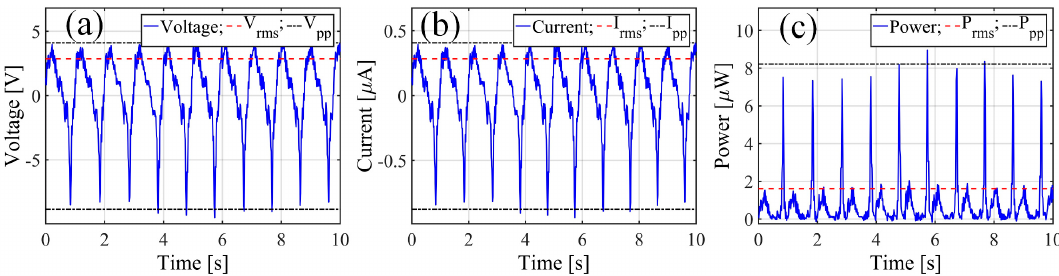
Figure 4. Output responses of the Stretchable TrEG while elbow motion ( a ) voltage, ( b ) current and ( c ) corresponding power for RL of 10.1 M Ω